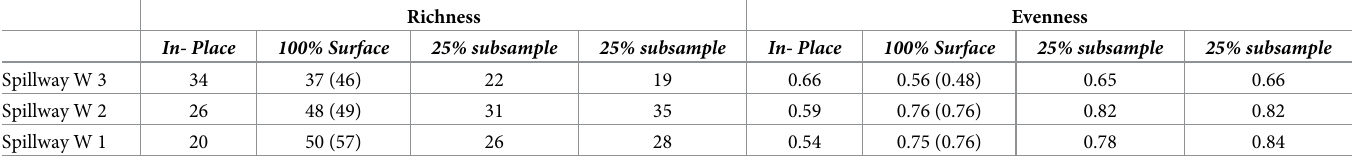
Table 4. Subsample diversity metrics. Richness and evenness for the in-place samples, 100% surface samples, and 25% subsamples for the brachiopod and mollusk data- set. Surface sample values are for only the one collector who sampled from all surfaces. The values in parentheses are those for all collectors’ samples combined, and are the same as those in Table 2.